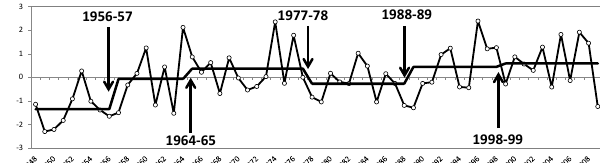
Figure 2. Normalized planetary wave amplitude index (PWAI) from 1948 to 2008 for 55–75 ◦ N and 70–20hPa with identified regime shift periods and approximate shift dates. Regime shifts